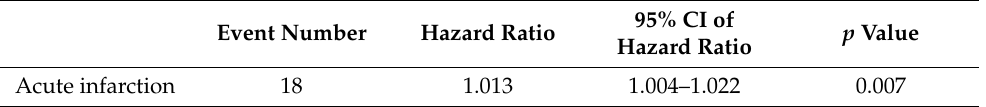
Table 5. Relationship between ALP and acute